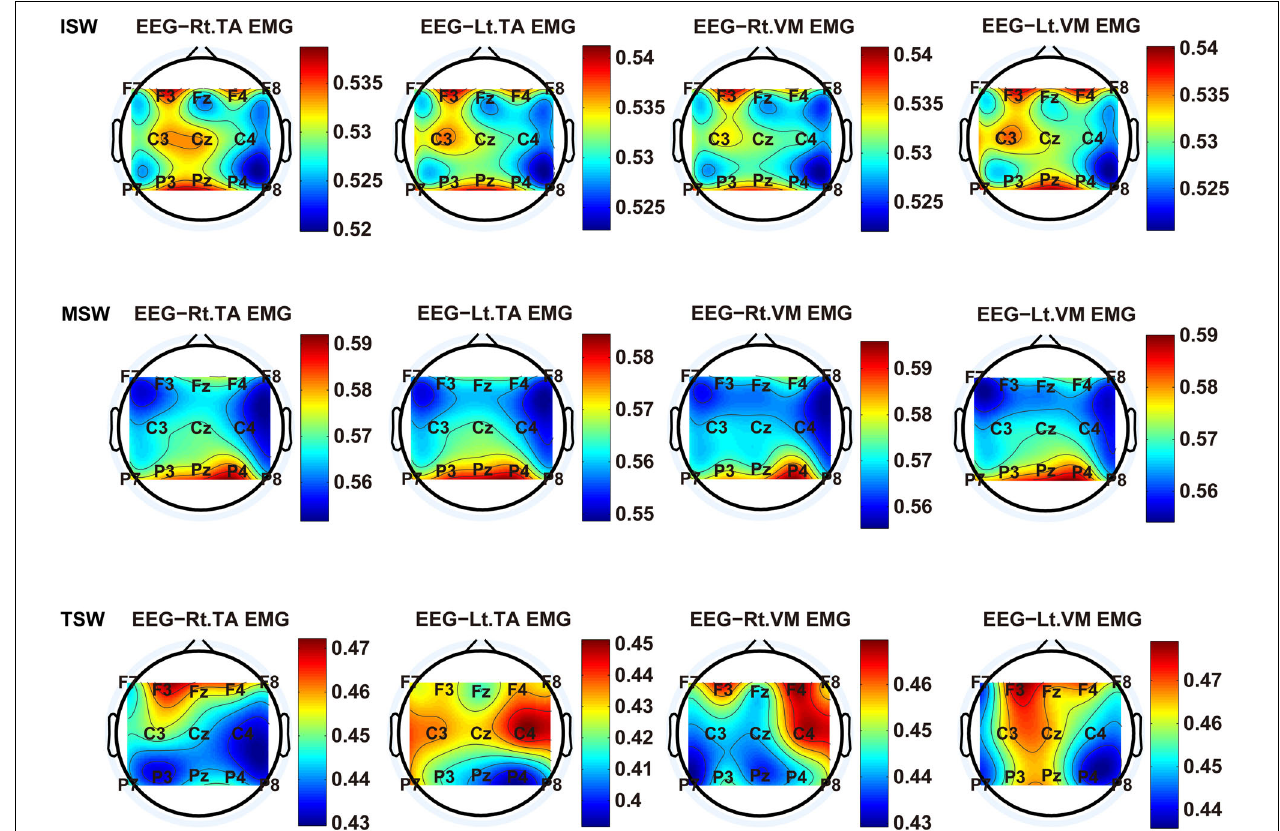
FIGURE 6 | The TFCMI topography between EEG (beta band) and sEMG (TA and VM) of the swing phase (ISW, MSW, and TSW).